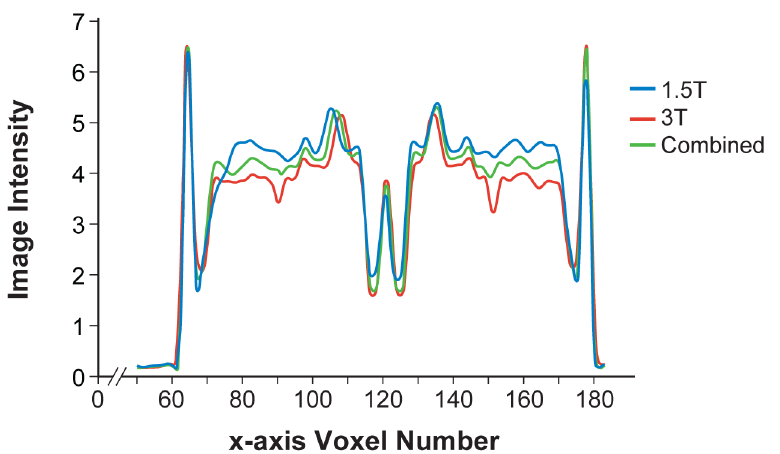
Figure 2. Representative intensity profile from a location including gray matter, white matter, and cerebrospinal fluid. Image intensity profile chart along the x axis at y=141 and z=79 showing intensity profiles for all three templates.